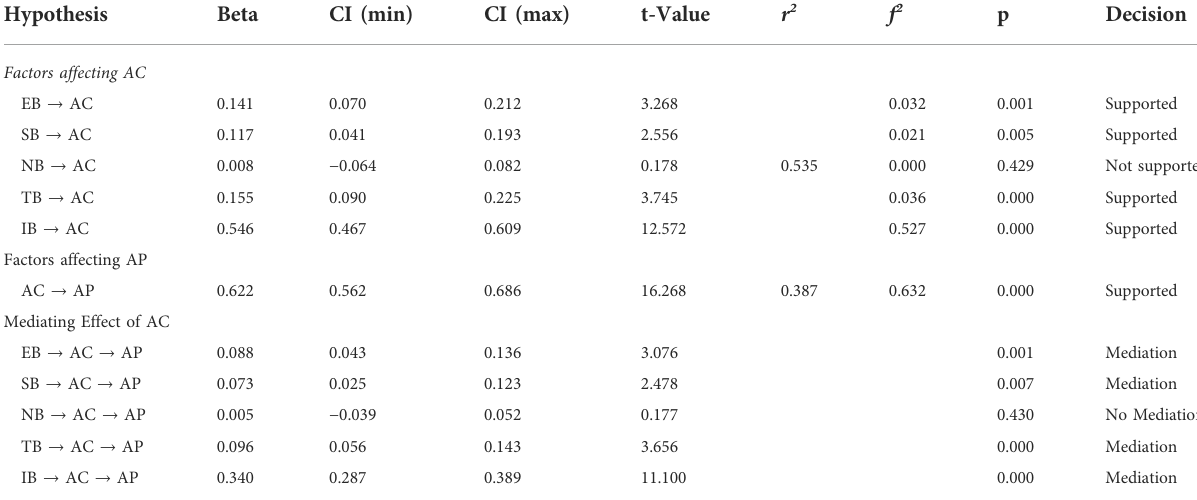
TABLE 5 Hypothesis